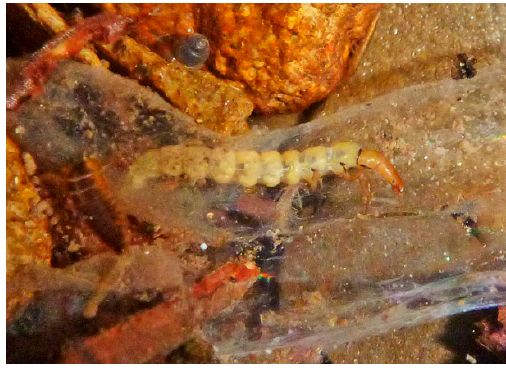
Figure 4. Larva of Wormaldia sp. (Philopotamidae) in its filter net. © W. Graf.